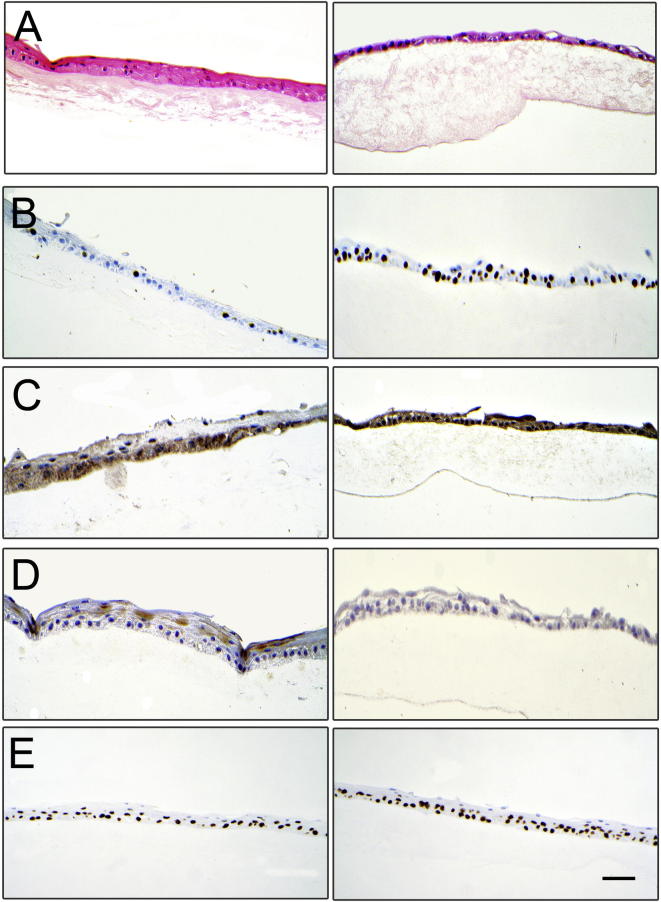
Histological images showing cultures on frozen non decellularised HAM in the left column and cultures on HAM decellularised with 0.5% SDS without γ-irradiation on the right column. (A) Haematoxylin and eosin stain, (B) Ki67 expression, (C) ABCG2 expression, (D) CK12 expression (E) ΔNp63 expression. Scale bar is 100 µm.